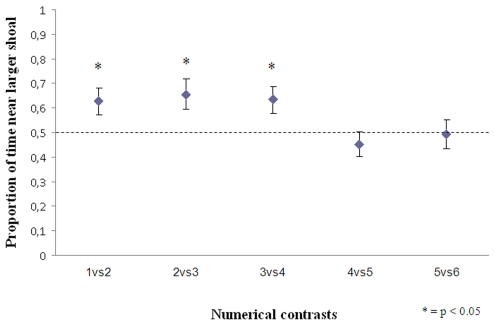
Results of experiment 2.Newborns proved to be able to discriminate shoals differing by one individual up to 4 units.